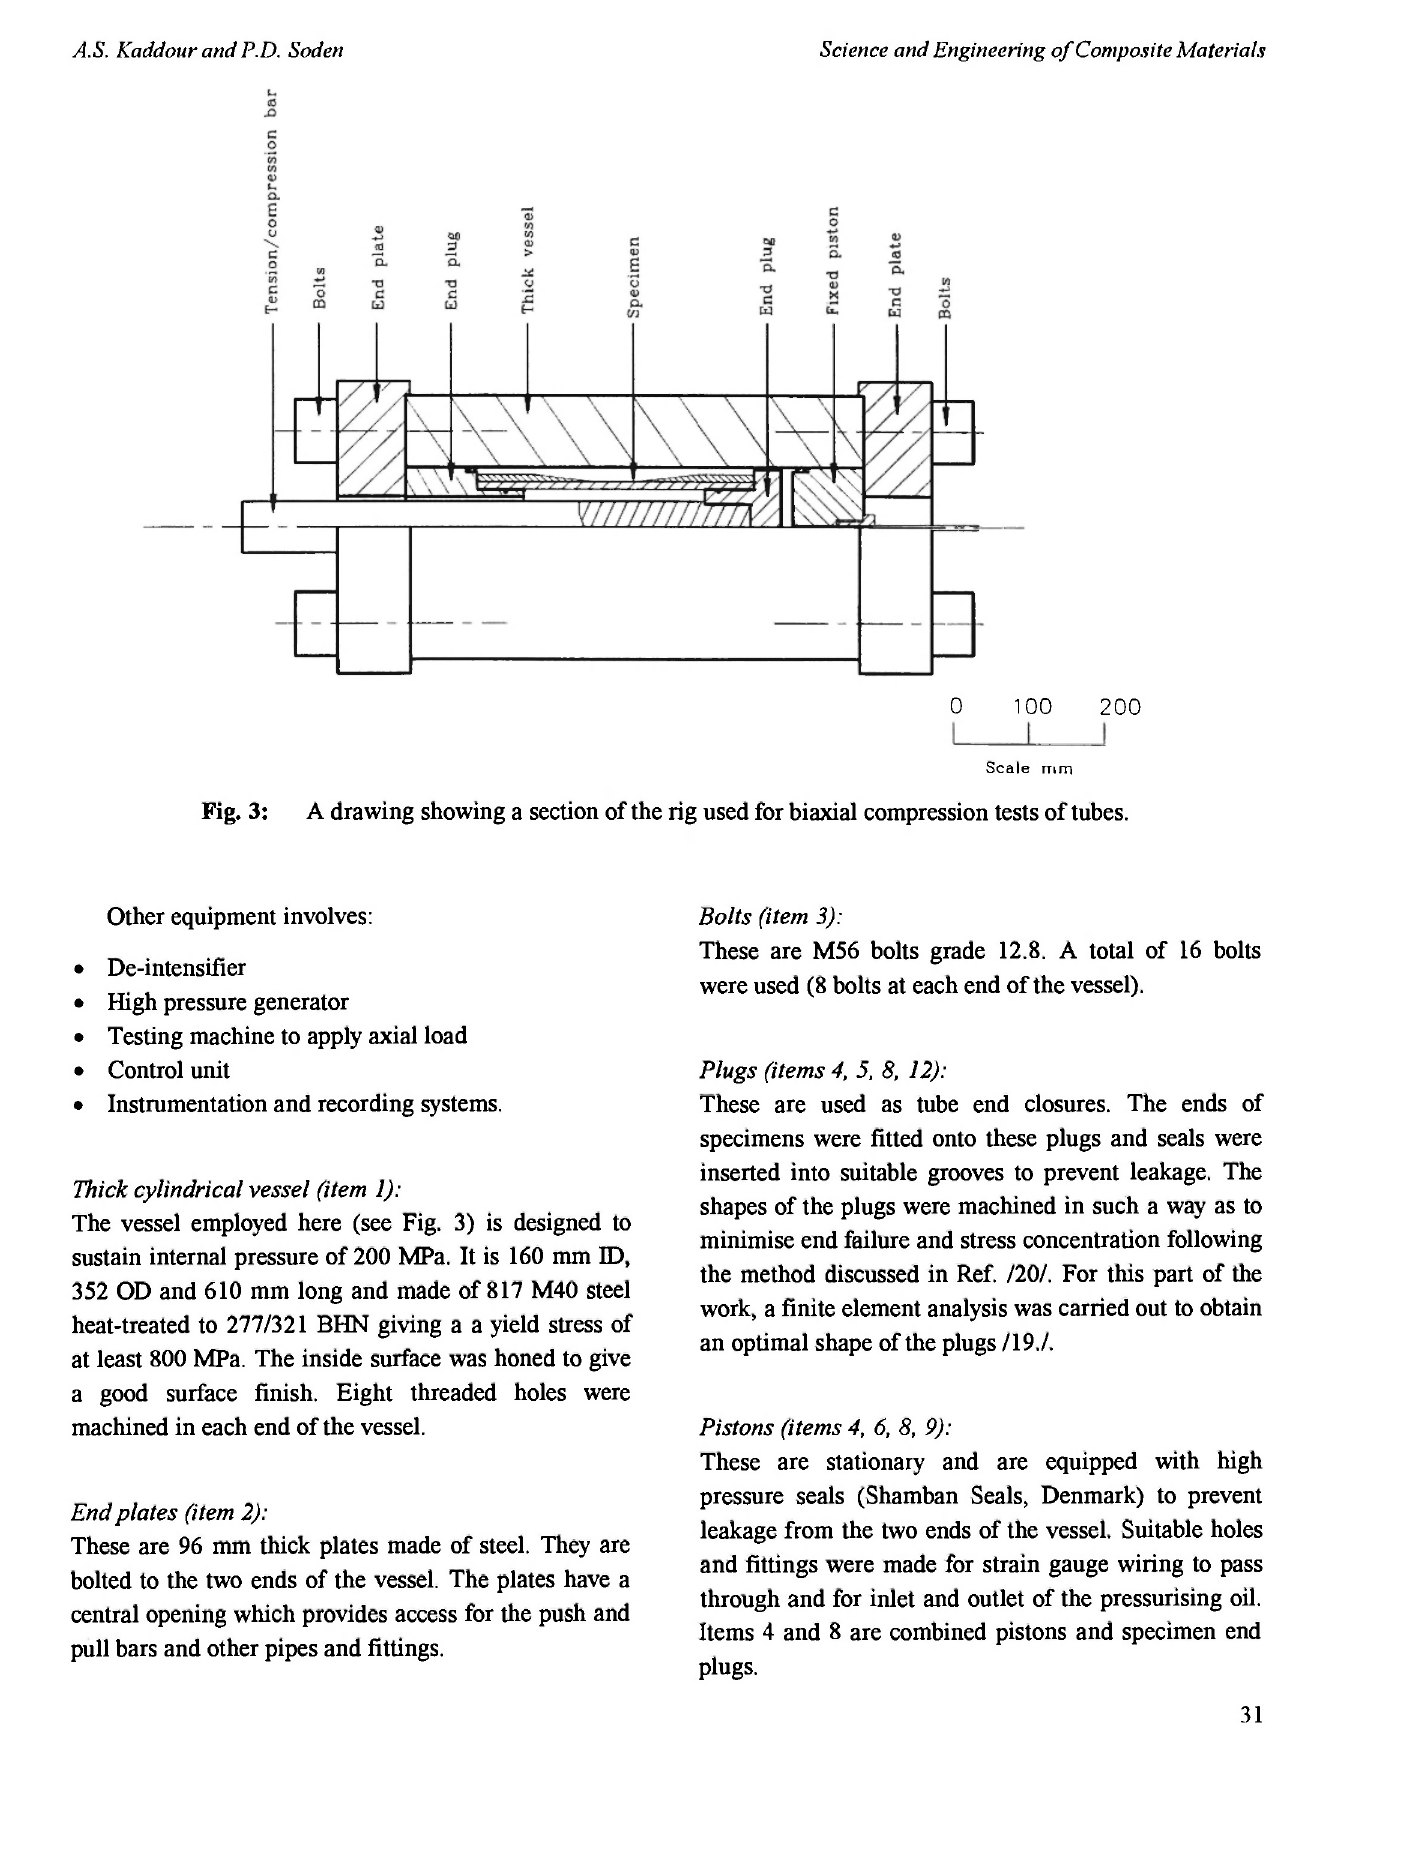
Fig. 3: A drawing showing a section of the rig used for biaxial compression tests of